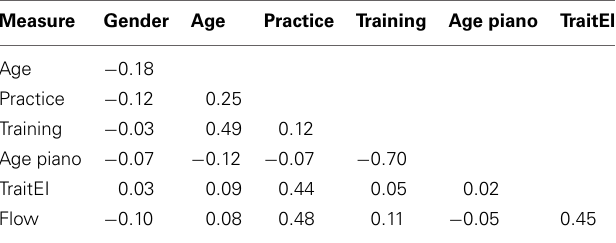
Table 3 | Pearson product-moment correlations between the average flow score and six predictors ( N = 62).